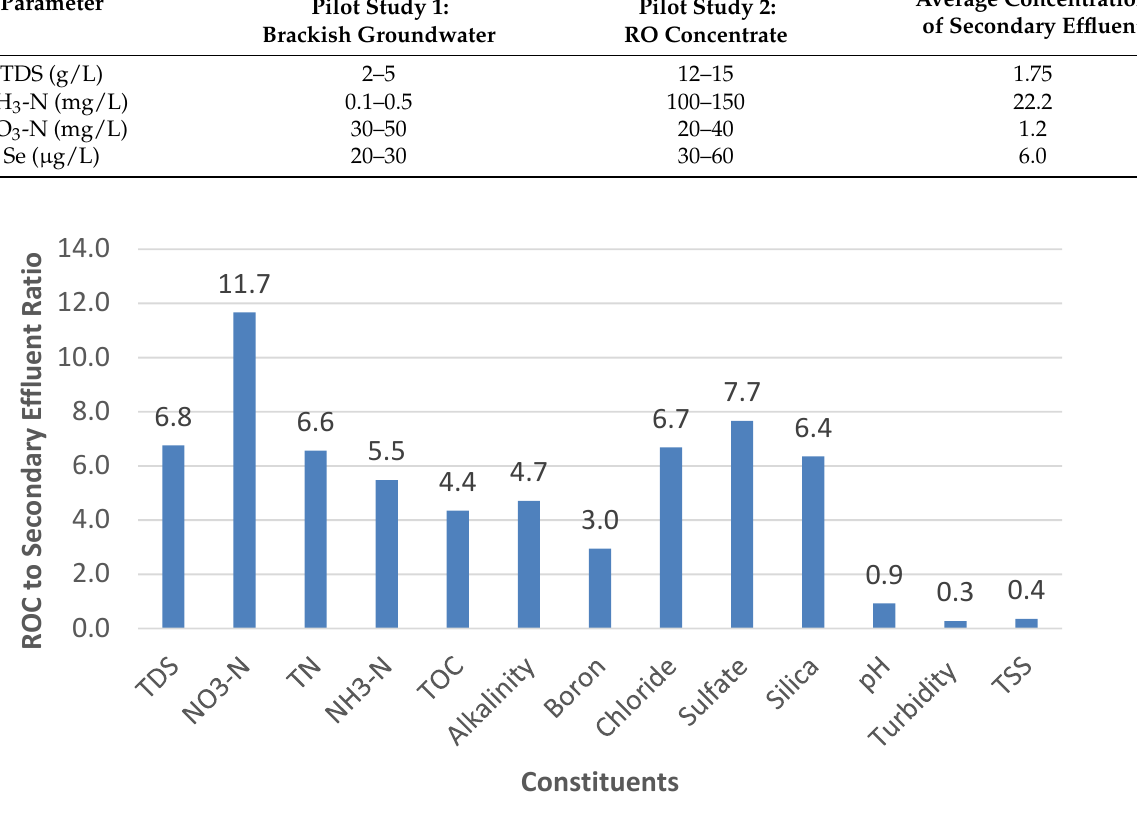
Figure 11. Construction of the constructed wetland around the visitor’s center of the AWPF.